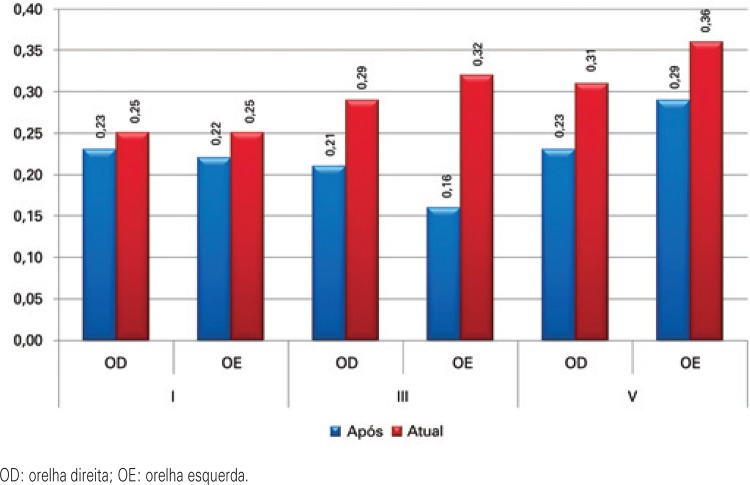
Amplitude média das ondas I, III e V nas avaliações após treinamento e atual